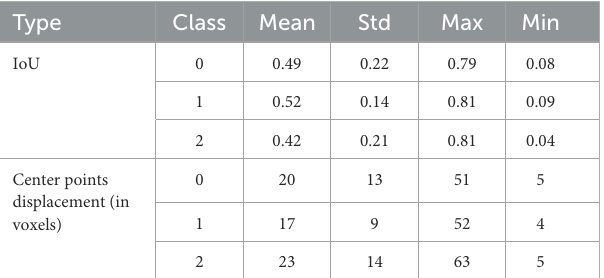
TABLE 1 Quantitative results from the region of interest detection